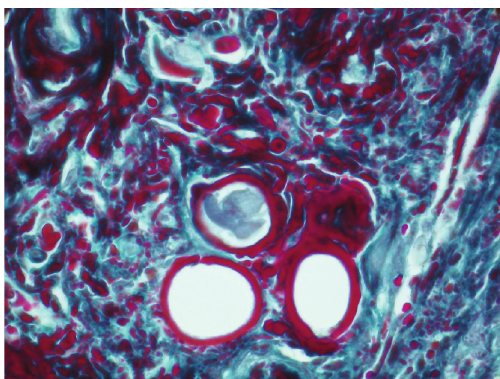
Figure 1: Immunohistologic analysis of submandibular salivary gland biopsy showing deposits of light chain monoclonal immuno- globulin in the perivascular space and connective tissues. Deposits are brick-red after Masson’s Trichrome